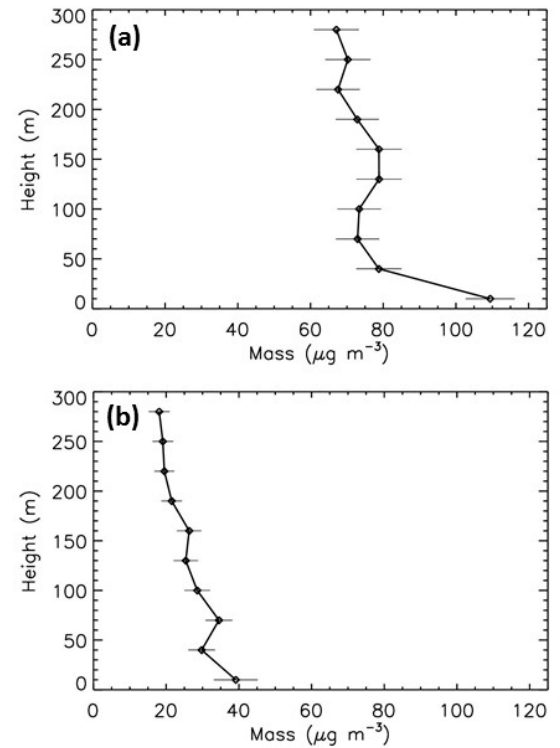
Figure 12. Evolution with height of LOAC PM10 mass concentrations during the spring pollution events. ( a ) 14 March 2014; ( b ) 17 March 2015.